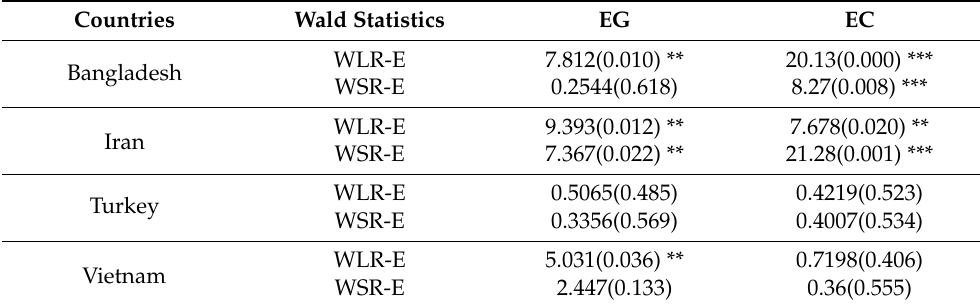
Table 10. Wald test result.